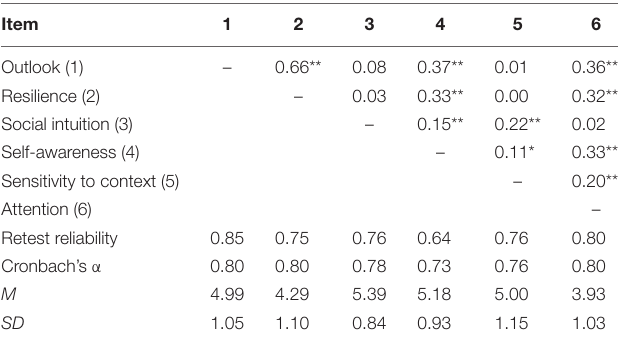
TABLE 5 | Reliability and descriptive statistics of the ESQ in Study II.